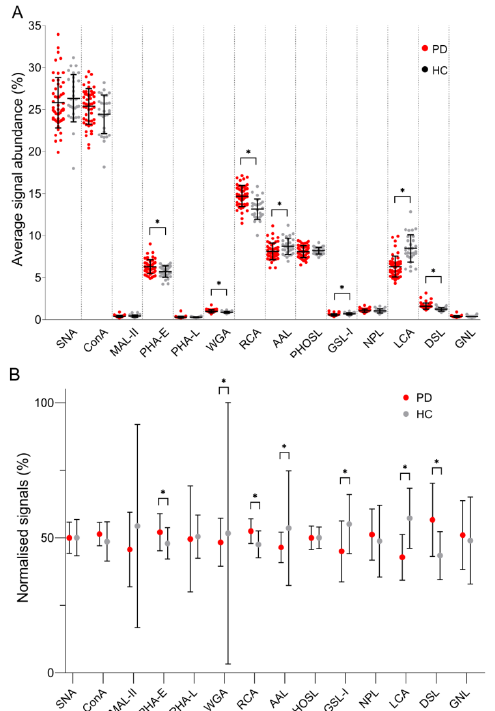
Figure 1. ( A ) Relative signal abundances obtained for each lectin used in the lectin-based microarray analysis of fibrinogen samples, ( B ) the contribution of each group (PD and HC) calculated as the portion of the sum of signals obtained for each lectin. ESRD patients on peritoneal dialysis (PD), healthy controls (HC). Relative abundances are given together with standard deviation, while the Mann-Whitney U test p -value < 0.05 is labelled with “*”.